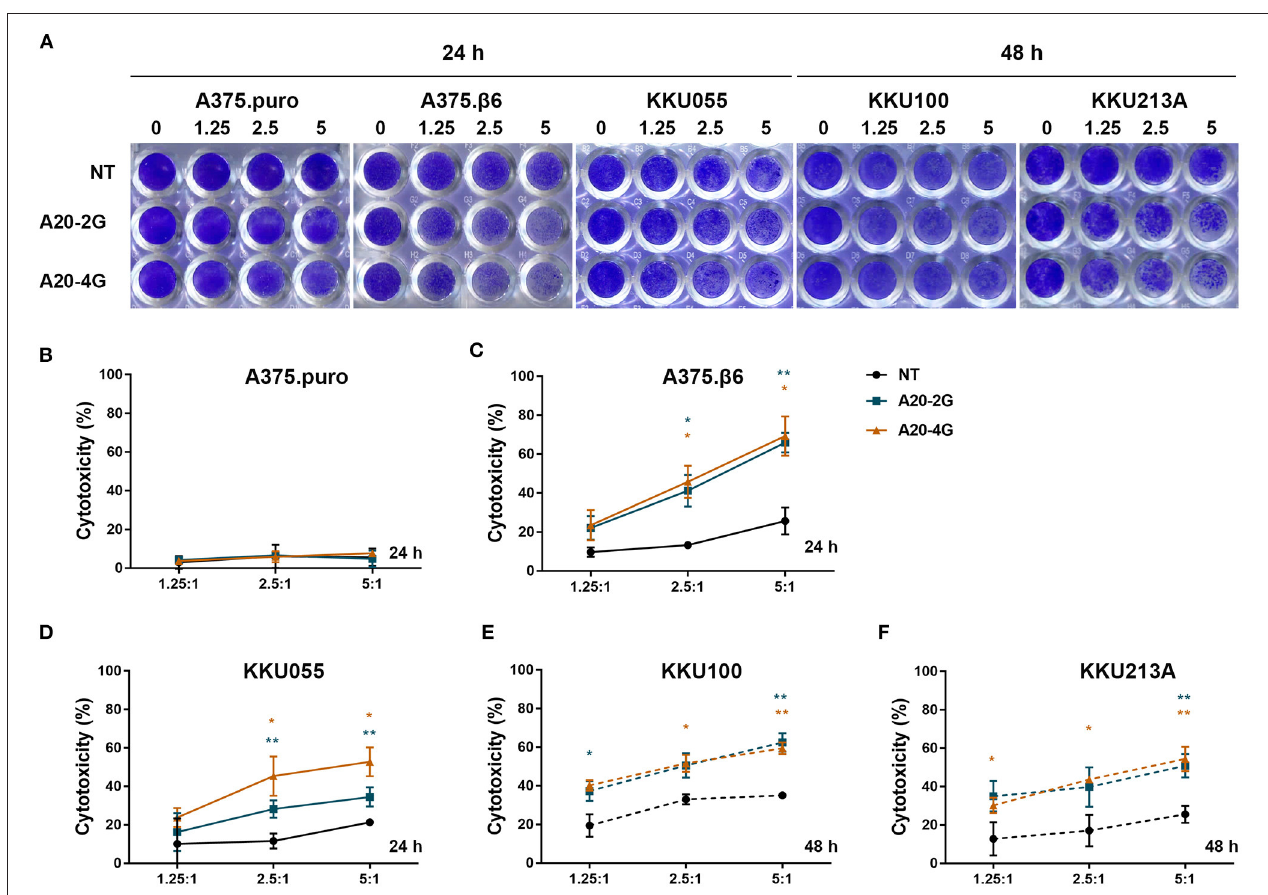
FIGURE 4 | Cytotoxic effects of A20-2G and A20-4G chimeric antigen receptor (CAR)-T cells on integrin α v β 6-negative A375.puro cells, integrin α v β 6-positive A375. β 6 cells, and three integrin α v β 6-positive cholangiocarcinoma (CCA) cell lines, including KKU055, KKU100, and KKU213A. The effector CAR T cells were co-cultured with target cells at the indicated effector to target (E:T) ratios (1.25:1, 2.5:1, and 5:1) for 24h ( solid line ) or 48h ( dashed line ). (A) Cytotoxicity of target cells after co-culturing with effector cells quantified by crystal violet staining assay. Integrin α v β 6-negative A375.puro cell line served as negative control while integrin α v β 6-positive A375. β 6 cells was served as positive control. (B) Cytotoxic effects of A20-2G and A20-4G CAR T cells on integrin α v β 6-negative A375.puro cells with non-transduced (NT) T cells used as a control for comparison. (C) Cytotoxic effects of A20-2G and A20-4G CAR T cells on integrin α v β 6-positive A375. β 6 cells with NT T cells used as a control for comparison. Cytotoxic effects of A20-2G and A20-4G CAR T cells on integrin α v β 6-positive KKU055 (D) , KKU100 (E) , and KKU213A (F) cells as compared to the killing activity of NT T cells on the same target cells. Percentage of cytotoxicity relative to the total number of tumor cells alone (set at 0% cytotoxicity) from three independent experiments presented as mean ± standard error of the mean (SEM) (* p < 0.05, ** p <